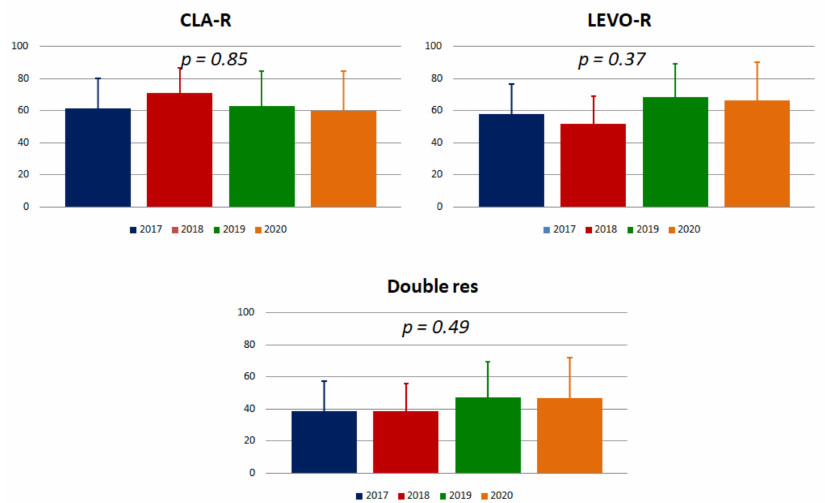
Figure 2. Trends of clarithromycin and levofloxacin resistance in patients with at least one eradication failure from 2017 to 2020. Histograms show rates and standard deviation. CLA-R: resistant to clarithromycin; LEVO-R: resistant to levofloxacin.